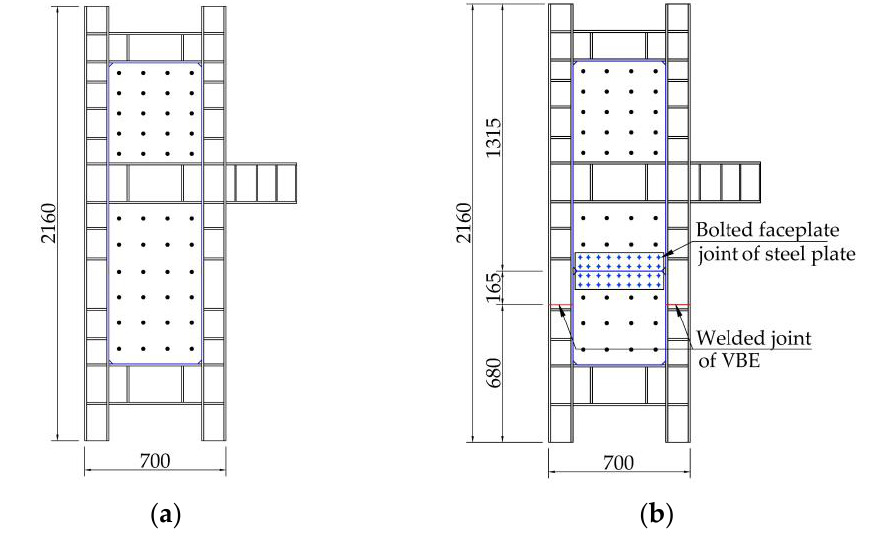
Figure 5. Details of steel plate connection (unit: mm). ( a ) CS-1, CS-3; ( b ) CS-2.